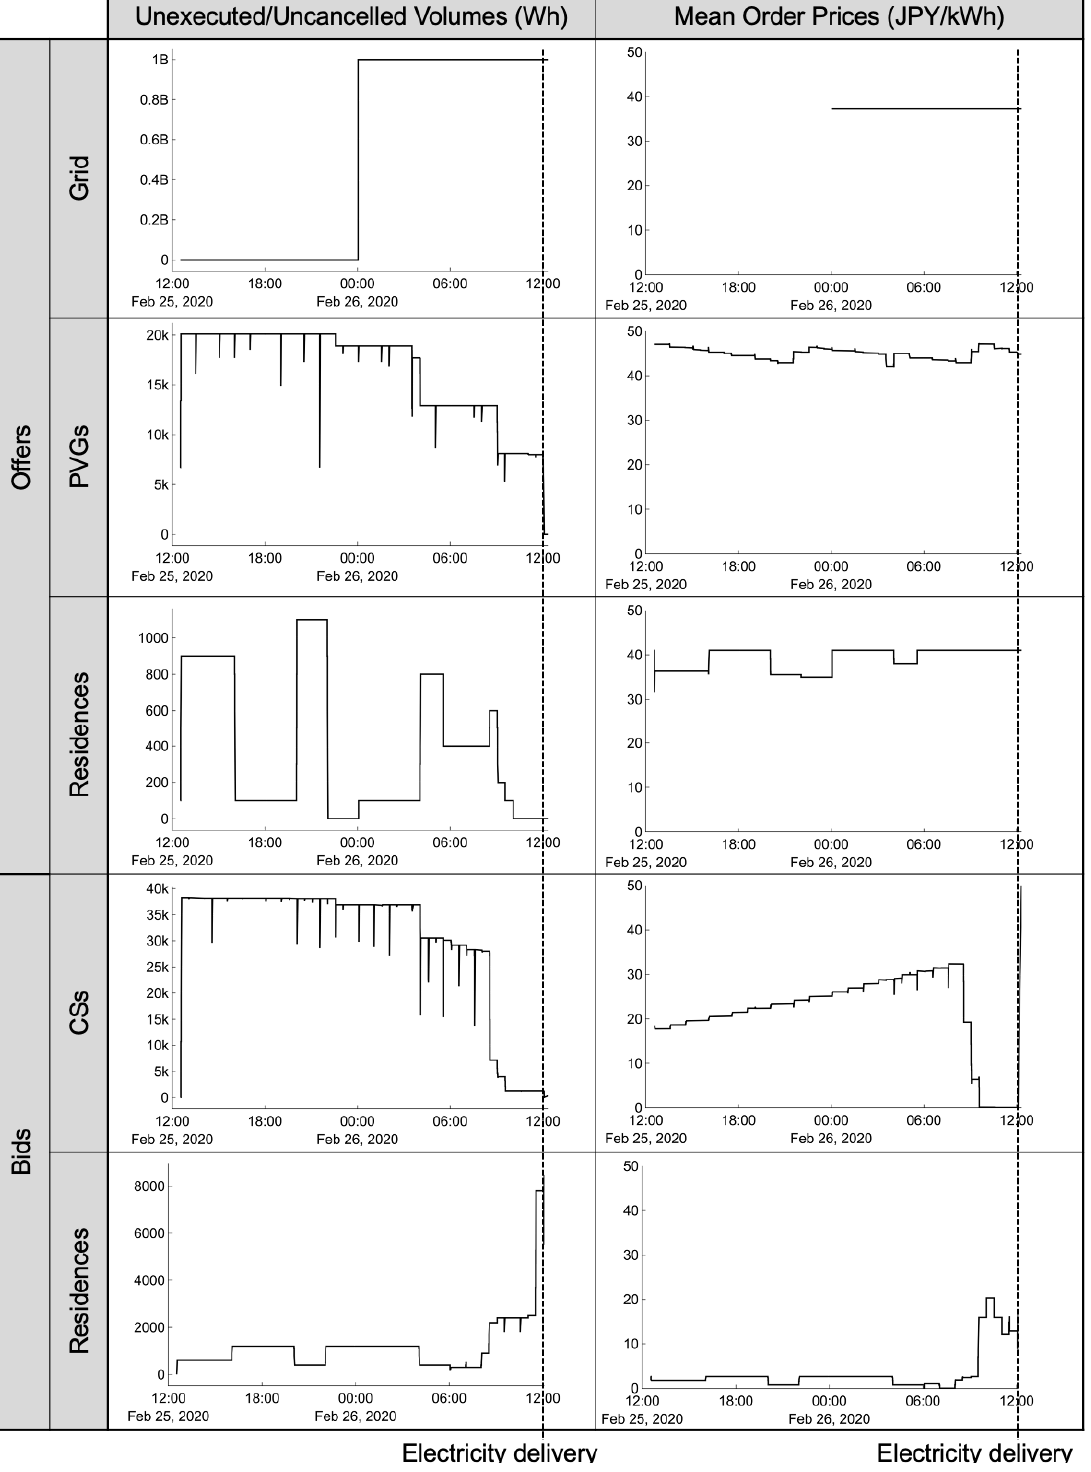
Figure 17. Offers and bids for electricity delivery from 12:00 to 12:30 on 26 February 2020.